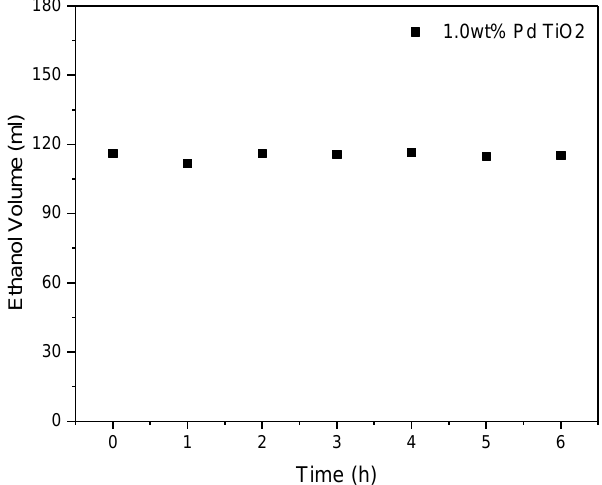
Figure 11. Ethanol changes with irradiation time. Conditions: photocatalyst concentration 0.15 g/L, argon atmosphere, 2.0 v/v% ethanol, pH = 4 ± 0.05 and near-UV light. Standard deviation: ±3.0%.